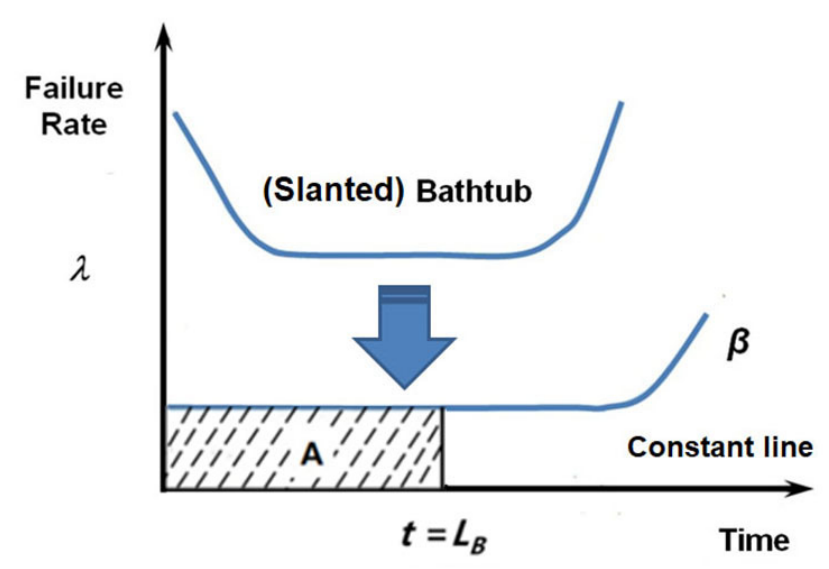
Figure 2. Bathtub curve and straight line.